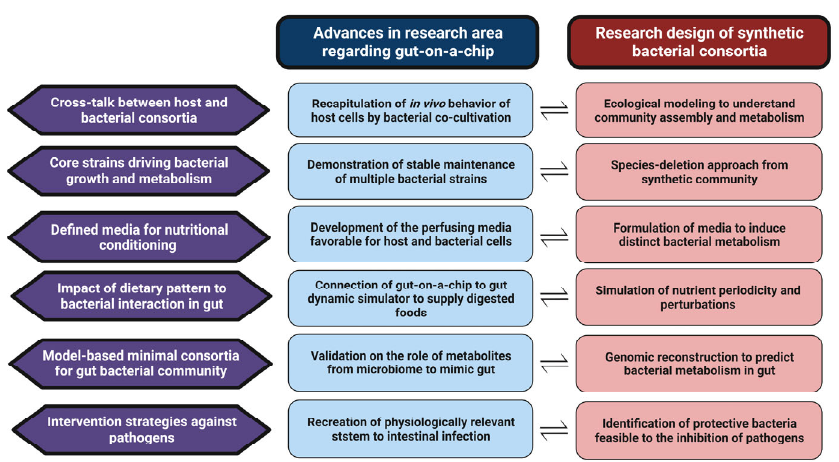
Figure 2. Schematic diagram depicting strategies to integrate study design of bacterial co-culture into gut-on-a-chip (created with www.biorender.com (accessed on 22 February 2023)).